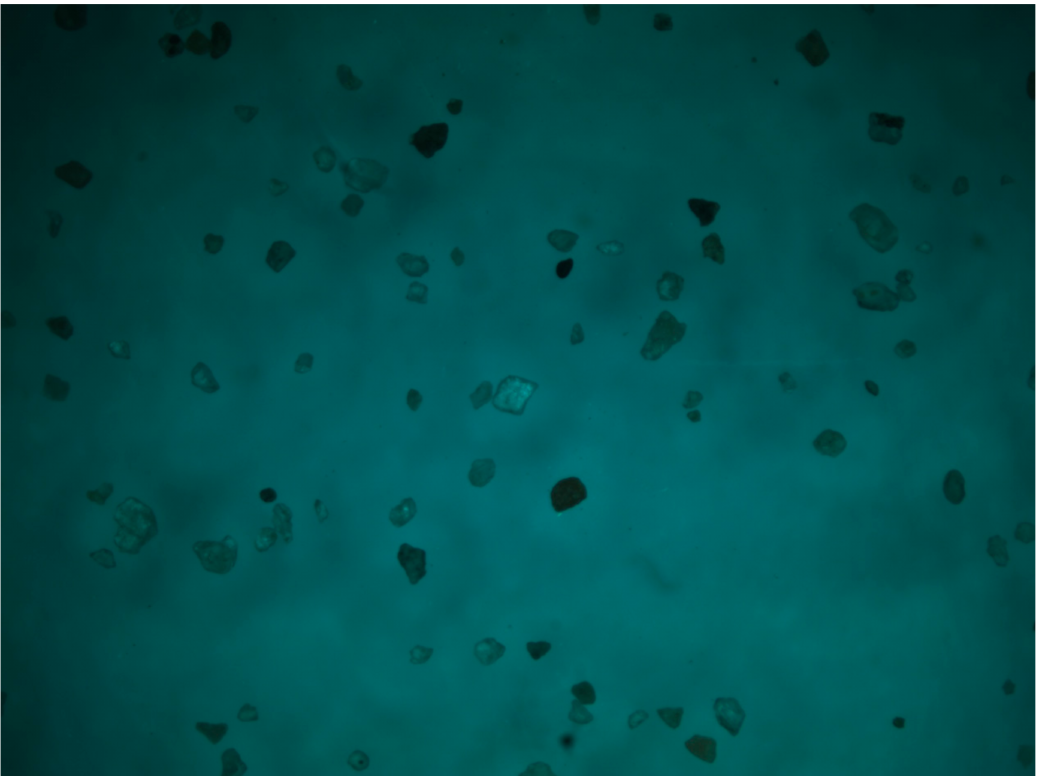
Figure 13. Particles in non-Newtonian